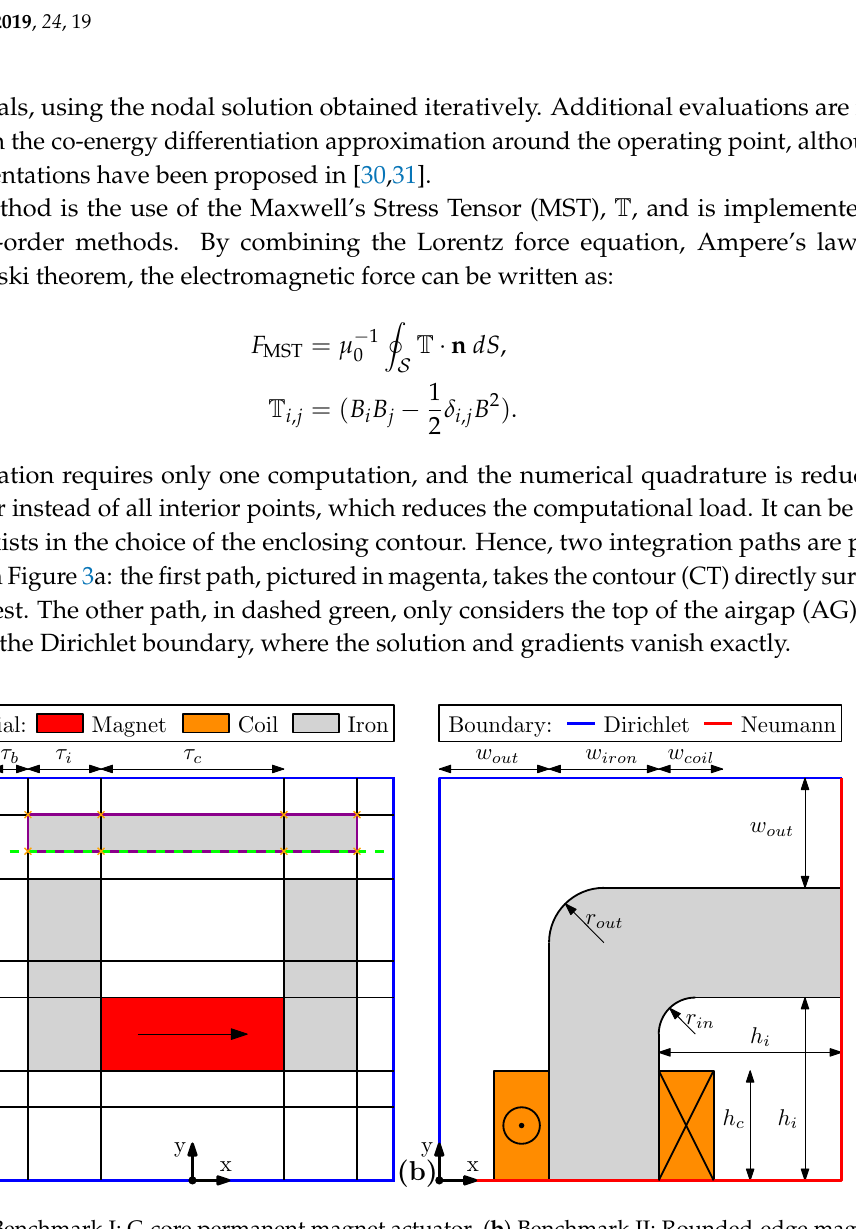
Figure 3. ( a ) Benchmark I: C-core permanent magnet actuator. ( b ) Benchmark II: Rounded-edge magnetic circuit